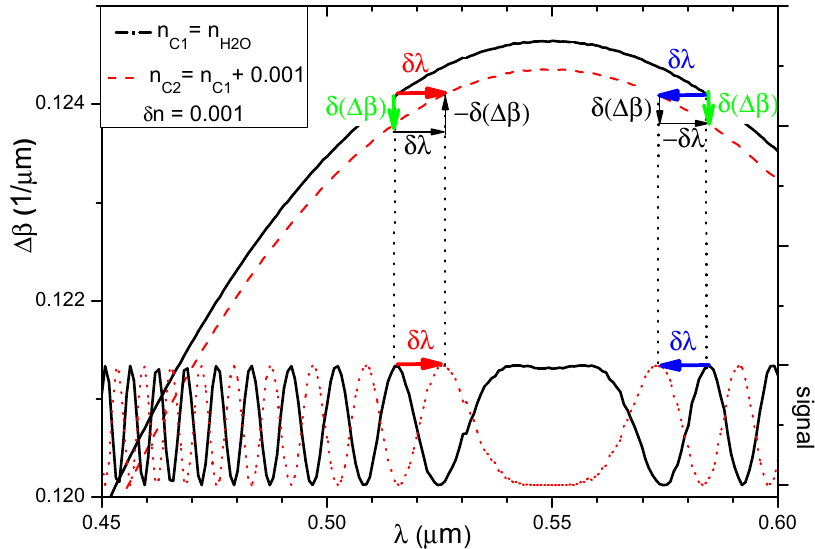
Figure 10. Left vertical axis: propagation constants di ff erence ∆ β between the modes for n H2O (solid line) and n c 2 (dash line). Right vertical axis: light intensity distribution for both covers after light propagates 12 mm.